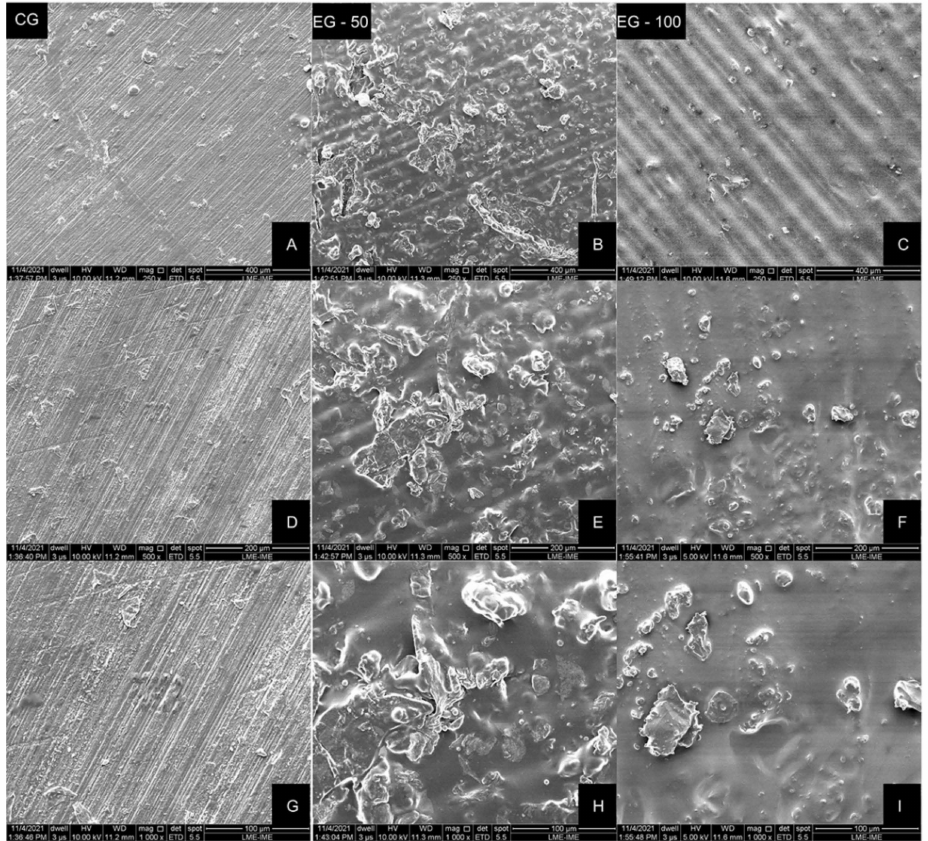
Figure 3. Representative SEM images of specimens from each group. ( A , D and G ), CG—auto- polymerizing acrylic resin. ( B , E and H )—EG-50, VP dental resin printed with 50 µ m resolution. ( C , F and I )—EG-100, VP dental resin printed with 100 µ m resolution. Magnifications: ( A – C ), × 250; ( D – F ), × 500; ( G – I ), ×